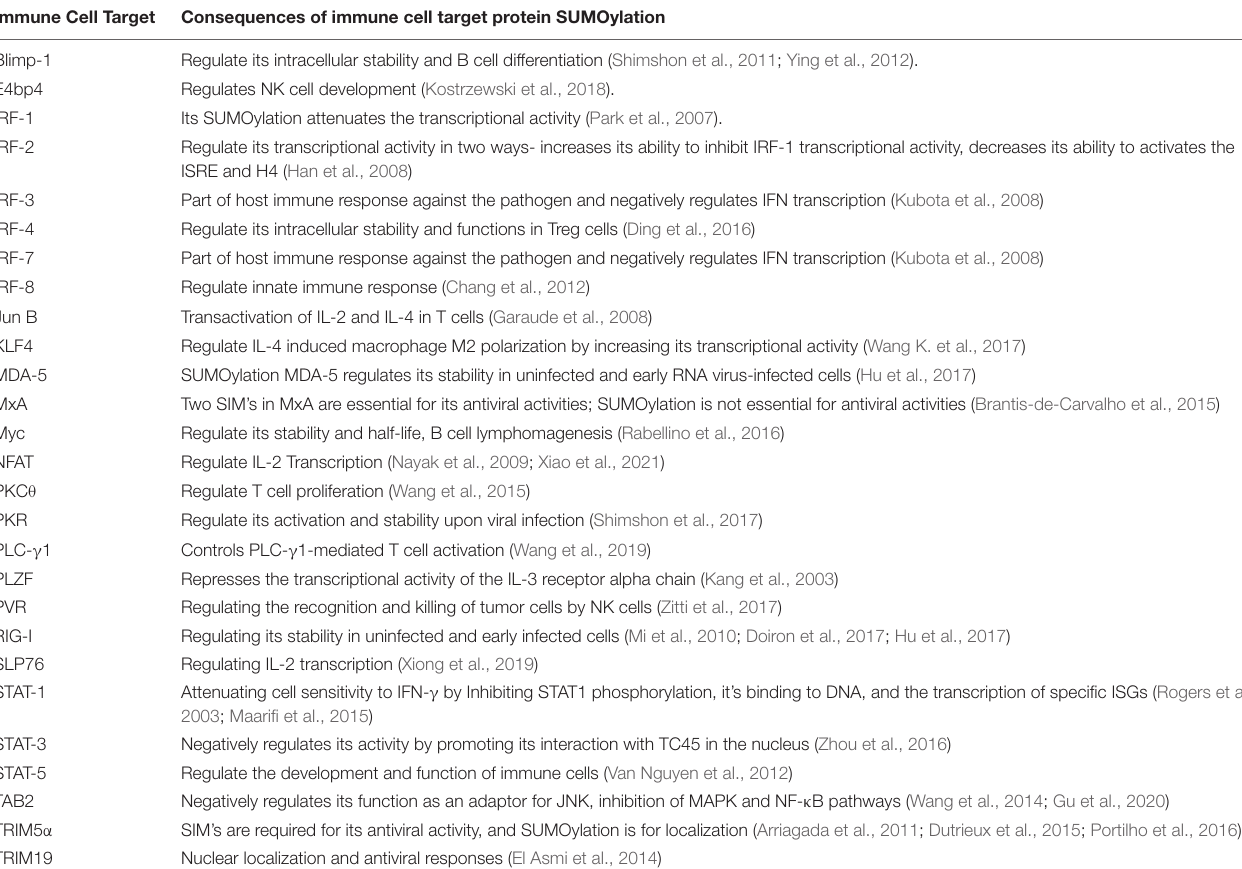
TABLE 3 | Immune cell target proteins, SUMOylation, and functional significance. Immune Cell